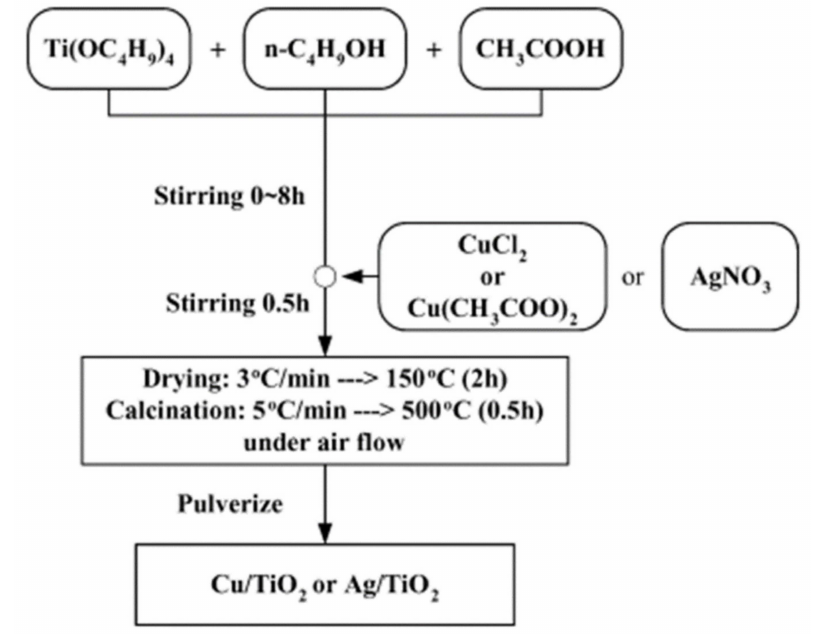
Figure 13. Sol-gel process for the development of the catalysts. Reprinted with permission from Elsevier, 19 December 2021 Ref.